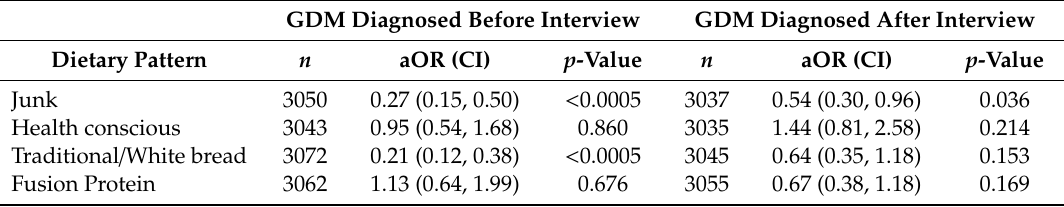
patterns included in the